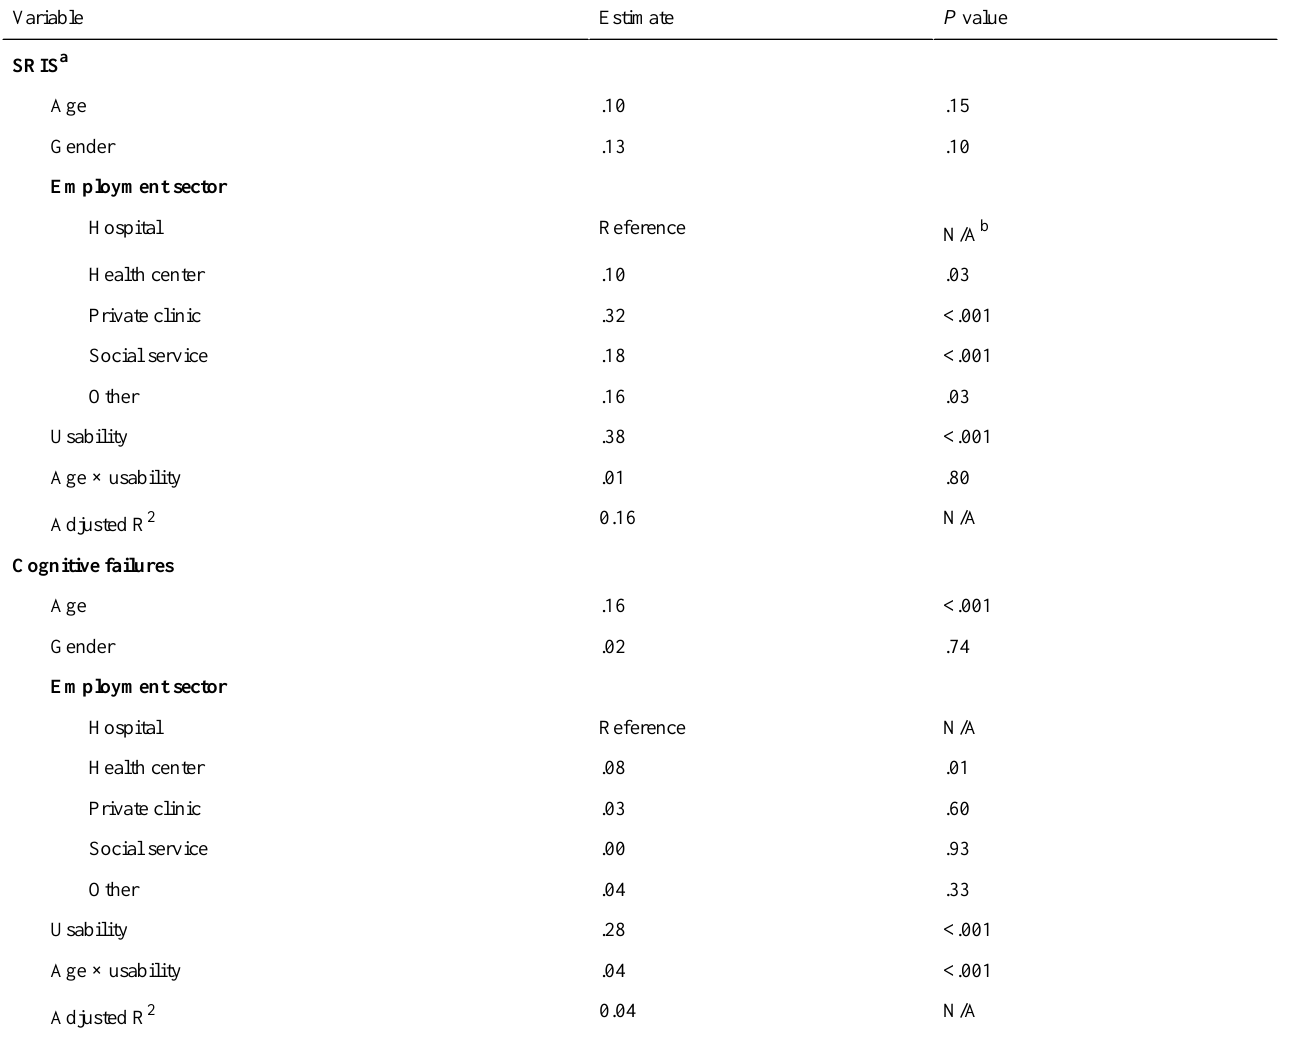
Table 2. The associations of age and EHR usability with stress related to information systems and cognitive failures.